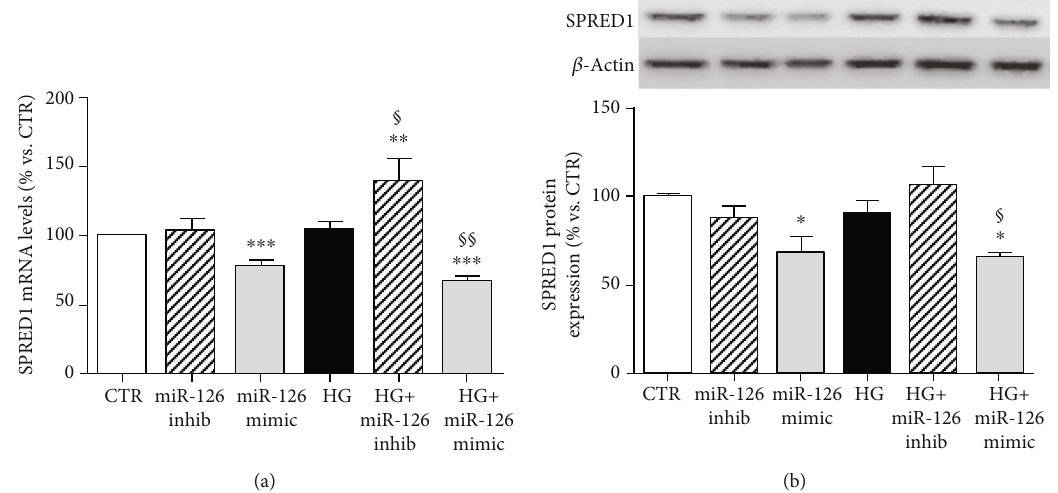
Figure 3: Expression of SPRED1 in ARPE-19 cells cultured for 24 hours in standard medium (CTR), silencing (inhib) and upregulating (mimic) miR-126 in control condition and in presence of high glucose (HG). (a) SPRED1 gene expression normalized vs. β -actin as housekeeping gene. (b) Representative Western blot analysis of SPRED1 protein expression with quanti fi cation of densitometries of relative bands. Data were expressed as mean ± SEM of fold induction relative to β -actin of three independent experiments ( n = 3 ). ∗ p < 0 : 05 , ∗∗ p < 0 : 01 , and ∗∗∗ p < 0 : 001 vs. CTR; § p < 0 : 05 and §§ p < 0 : 01 HG+mimic vs. HG.